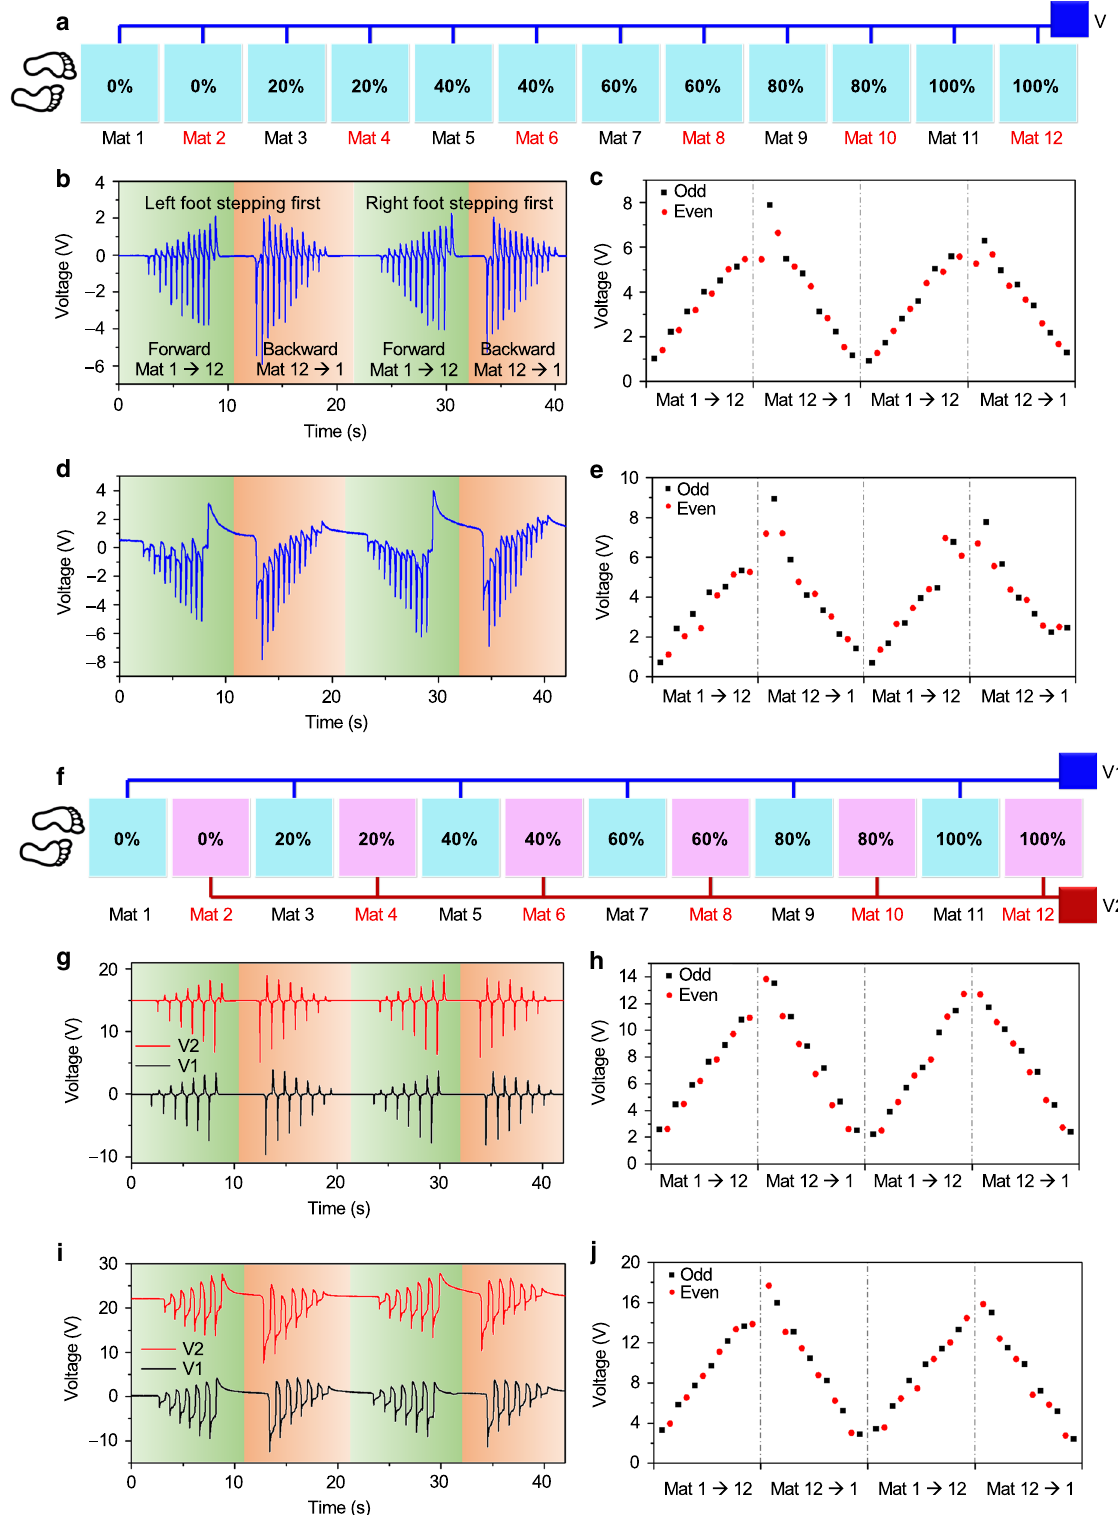
Fig. 3 Investigation of the electrode connection scheme. a The schematic diagram of the parallel connection of 12 DLES-mats into one output electrode. b – e The generated output voltages and corresponding peak-to-peak voltage magnitudes on b , c a 1 M Ω and d , e a 100 M Ω external load with two rounds of forward – backward walking. Large signal distortions and magnitude deviations from the ideal situations are found due to the overlapping of two opposite voltage pulses caused by simultaneous walking on the next DLES-mat and walking off the previous DLES-mat. f The schematic diagram of the interval parallel connection of all the DLES-mats into two output electrodes to address the above issue. g – j The generated output voltages and the corresponding peak-to-peak voltage magnitudes on g , h a 1 M Ω and i , j a 100 M Ω external load with two rounds of forward – backward walking. More ideal signal patterns and relative magnitudes can be achieved with the interval parallel connection